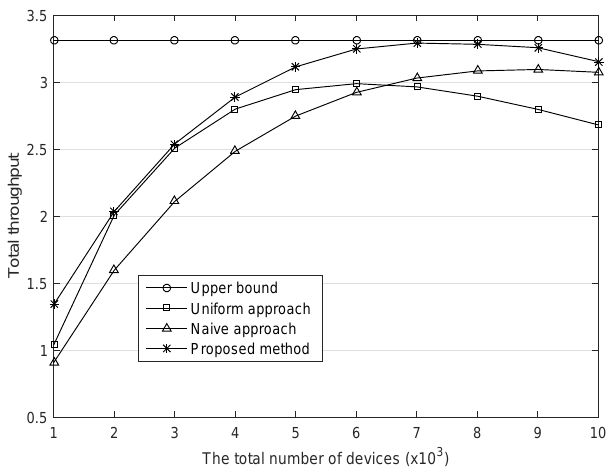
Figure 6. The comparison of the total throughput. The number of channel, N c is